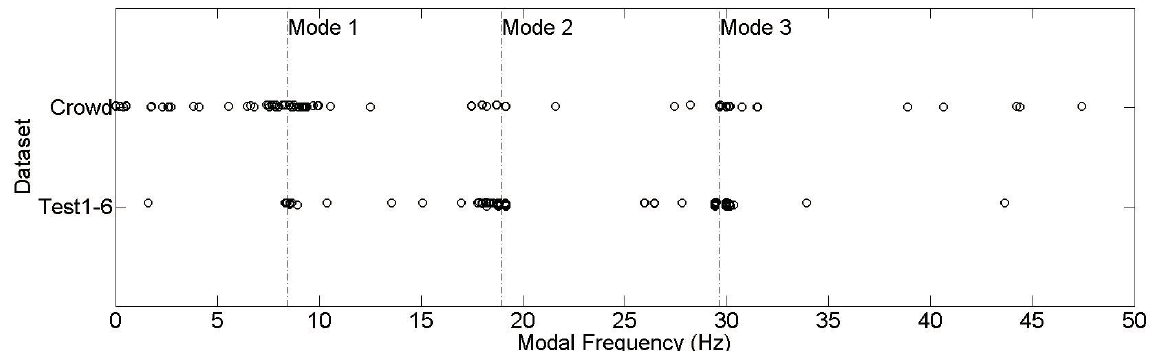
Figure 11. Modal identification results from Test 1–6 and crowdsourcing.